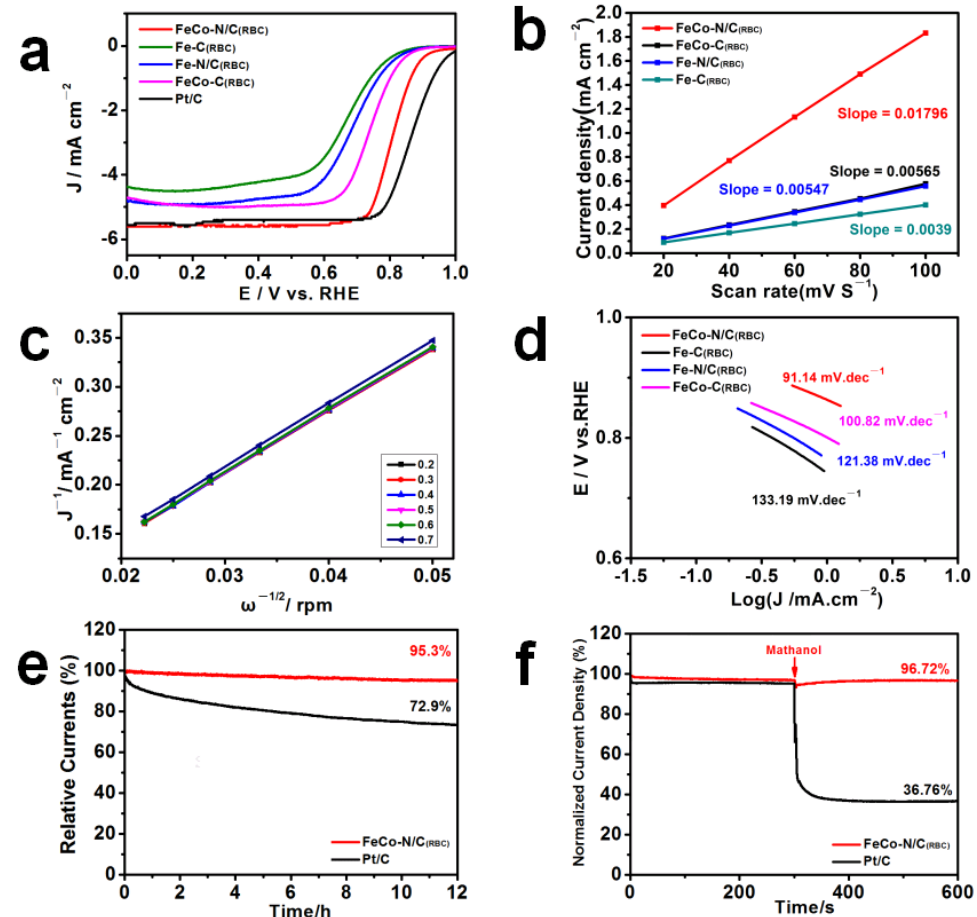
Figure 5. ( a ) Comparative LSVs at 1600 rpm for four catalysts, along with 20 wt% commercial Pt/C in O 2 saturated 0.1 M KOH solution. ( b ) The capacitive current as a function of the different scan rates of four catalysts for an estimate of the double-layer capacitance. ( c ) Kouteckye – Levich plots of FeCo-N/C (RBC) . ( d ) Tafel plots of four catalysts for the ORR. ( e ) i − t chronoamperometric responses of FeCo-N/C (RBC) and 20 wt% commercial Pt/C at 0.78 V in O 2 -saturated 0.1 M KOH. ( f ) i − t chronoamperometric responses of FeCo-N/C (RBC) and 20 wt% commercial Pt/C electrodes upon the addition of 3 M methanol.